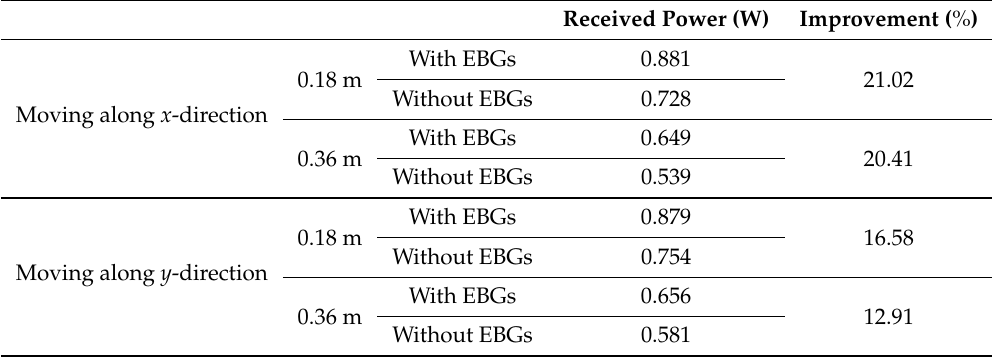
Table 2. Comparison of the received power when moving the power receiver along the x - and y